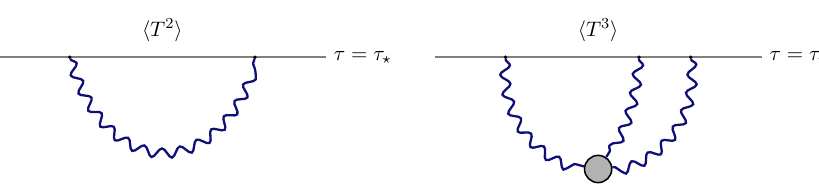
Figure 1 . Diagrams giving rise to the γ 2 and γ 3 to leading order. Wavy lines correspond to graviton bulk-to-boundary propagators. h i h i It should be noted that other references (such as [51, 52]) use similar diagrams to denote the entire in-in correlator, while for us the above diagrams only correspond to wavefunction coefficients. The three-point interaction vertex in the right diagram can arise from the Einstein-Hilbert term or a W 3 higher-derivative interaction (other diffeomorphism invariant interactions are redundant µνρσ with these